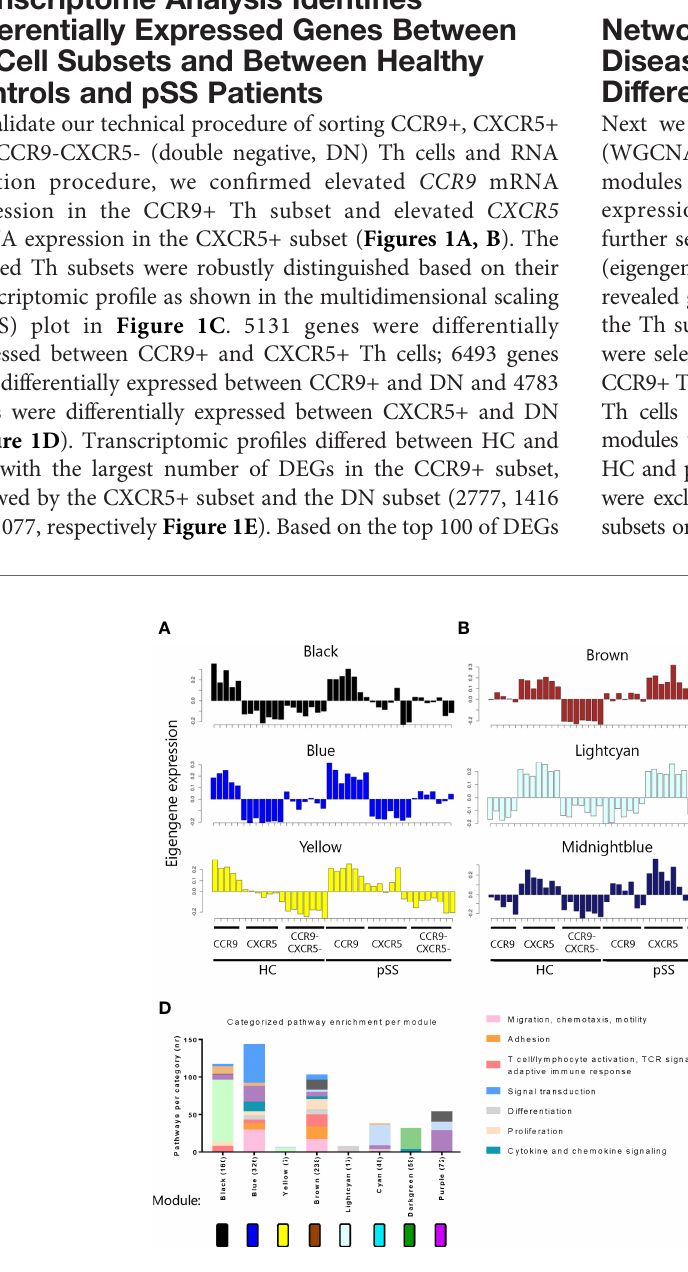
FIGURE 2 | Weighted gene co-expression network analysis (WGCNA) reveals networks of genes with coherent expression patterns involved in distinct Th cell functions. Modules with elevated eigengene expression in CCR9+ Th cells (A) or CXCR5+ Th cells (B) , and modules with differential eigengene expression between HC and pSS patients (C) are shown. Each bar represents the eigengene expression of one sample in the indicated Th cell subset of a donor. Pathway enrichment analysis reveals different pathways within the modules. Pathways are categorized, and categories are indicated by the colors in the legend. The number of pathways per category is shown. The total number of pathways per module is indicated behind the module name on the X-axis (D)